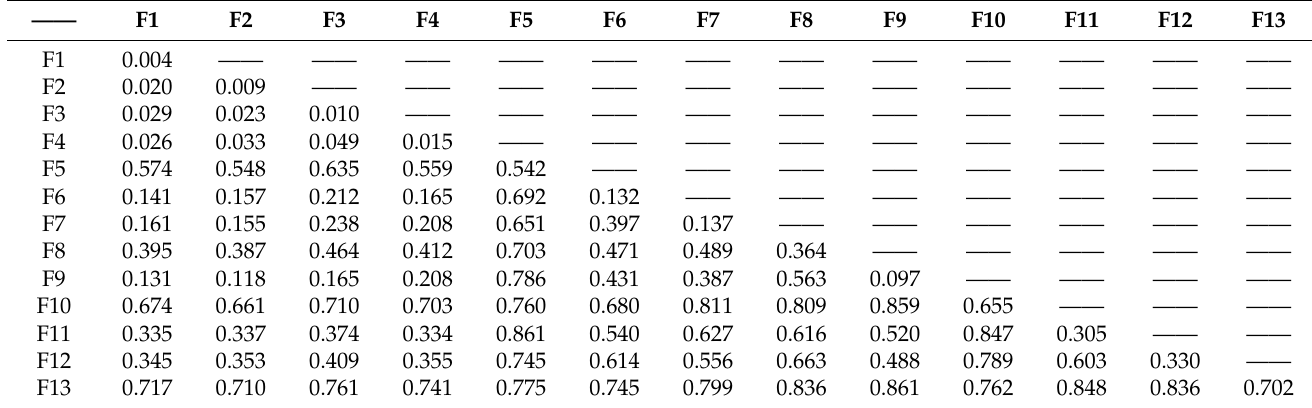
Table 7. Interaction analysis table of impact